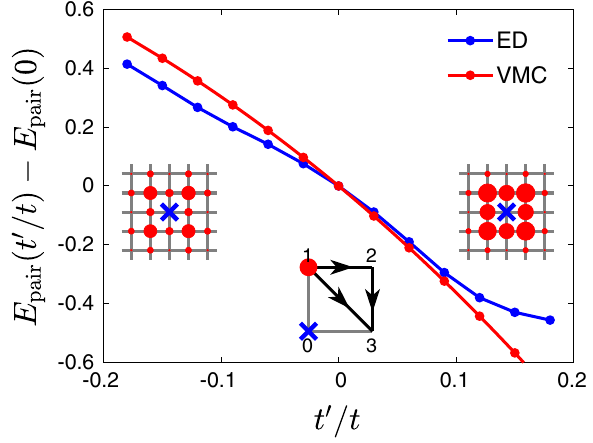
t 0 =t Þ as a FIG. 11. The two-hole pairing energy shift in E pair ð function of t 0 =t due to the NNN hopping t 0 term added to the t - J model. The VMC result (red dot) is determined by the same method used in Sec. IV with the largest subregion n ¼ 20 which is almost saturated to the extrapolation value. Insets: Similar to the plot in Fig. 5, the blue cross denotes one hole position and the red dots the distributions of the other hole as given by the hole- n h hole density correlator h n h i at t 0 =t ¼ − 0 . 2 (left top) and t 0 =t ¼ i j 0 . 2 (right top), respectively. The middle bottom inset further indicates the additional hopping of the hole along the diagonal direction (see the text). The ED result (blue dot) is also shown in the main panel as calculated by the definition in Eq. (32) on a 4 × 4 lattice with the OBC (which is comparable to the intrinsic size of the bound pair determined by